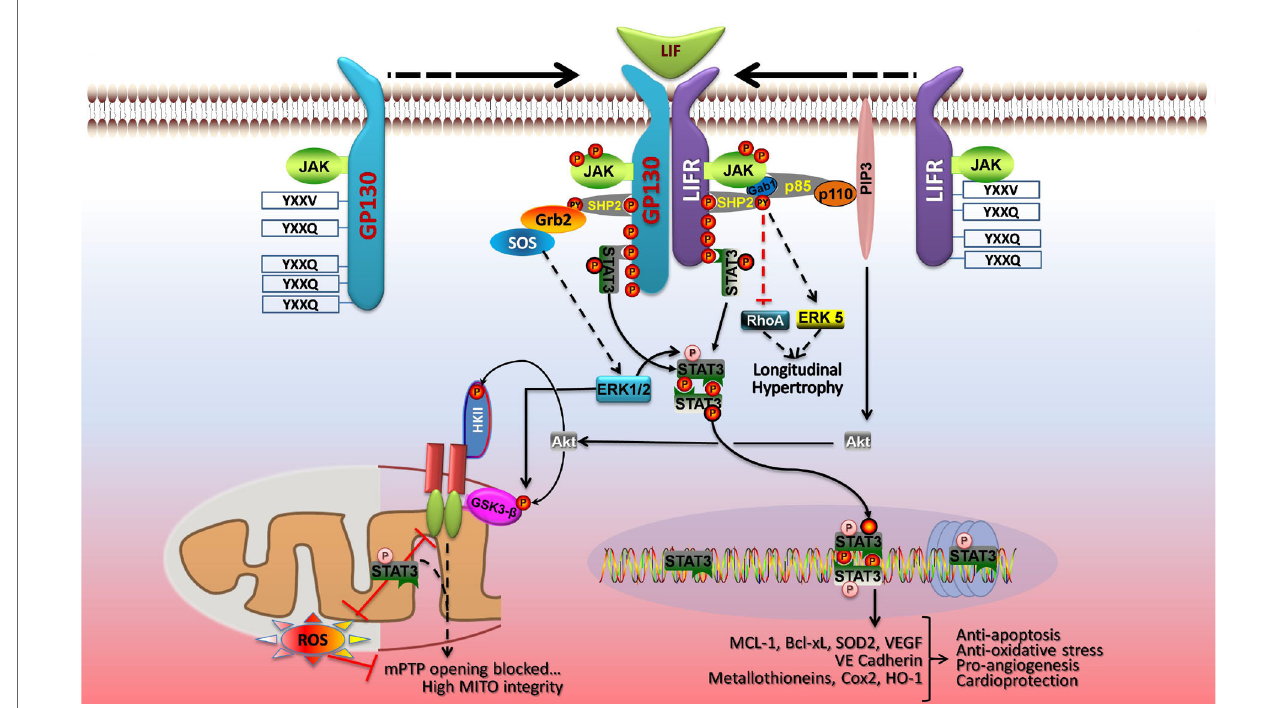
FiGURe 3 | LiF protects cardiac myocytes by both genomic and non-genomic means . Dimerization of gp130 and LIFR activates the associated JAK tyrosine kinases, which phosphorylate recruitment sites for STAT3 and STAT1 (YXXQ), and a scaffold protein SHP2 (YXXV) that is coupled to ERK1/2, ERK5, and phosphoinositide 3-kinase (PI3K)-Akt activation. STAT3 and the SHP2-based signaling pathways are linked to cellular protection and/or cell growth. JAK-mediated STAT3 phosphorylation on Y705 enhances its dimerization and DNA binding. Activated STAT3 induces expression of anti-apoptotic, anti-oxidative stress, and pro-angiogenic genes, and STAT3 S727 phosphorylation boosts gene transcription. In the nucleus, U-STAT3 may affect gene expression either as a transcription factor or by modulating chromatin structure. In parallel, STAT3 has protective actions on mitochondrial function. STAT3 optimizes mitochondrial respiration and limits ROS formation, thereby opposing mPTP opening and ensuring mitochondrial integrity. These non-genomic actions of STAT3 are enhanced by S727 phosphorylation. ERK1/2 and Akt are components of the RISK pathway of cardiac protection that is evoked by pre- and postconditioning. ERK1/2 has protective effects on mitochondria via phosphorylation and inhibition of GSK3- α / β , which prevents mPTP opening. PI3K-Akt signaling also inhibits opening of mPTP via phosphorylation of GSK3- α / β or mitochondrial hexokinase II (HKII). See text for additional details. Adapted with permission from Zouein et al.